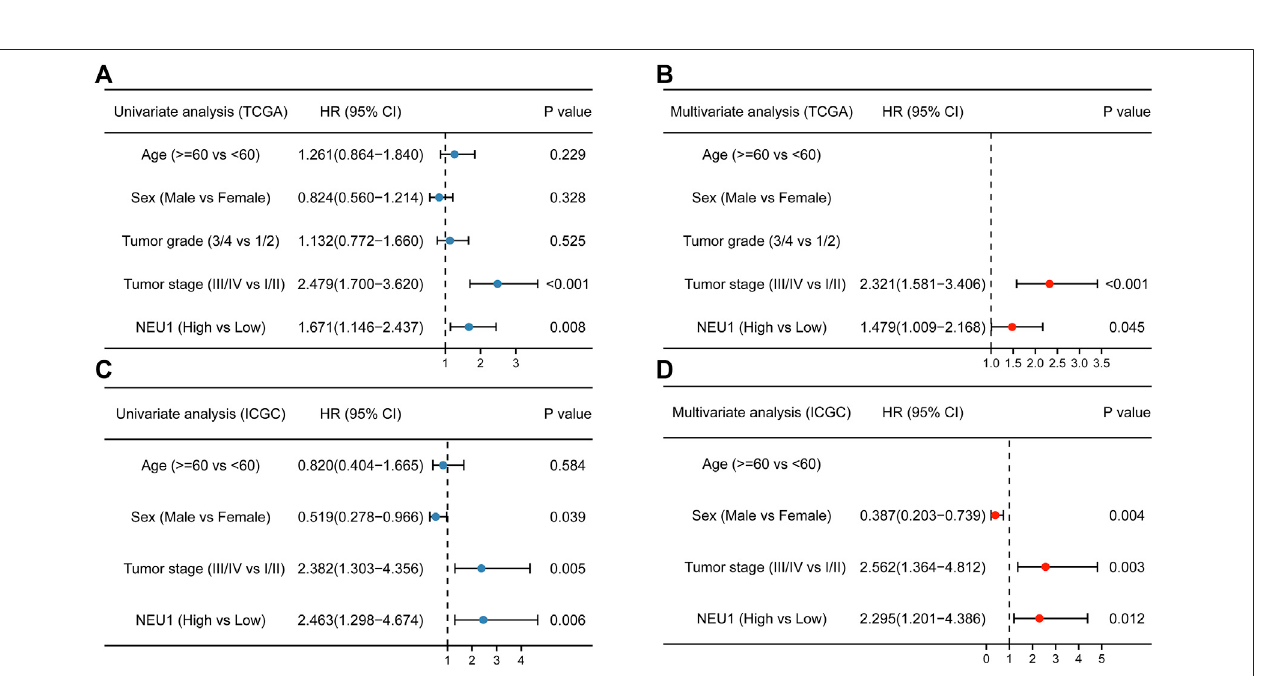
Frontiers in Molecular Biosciences |